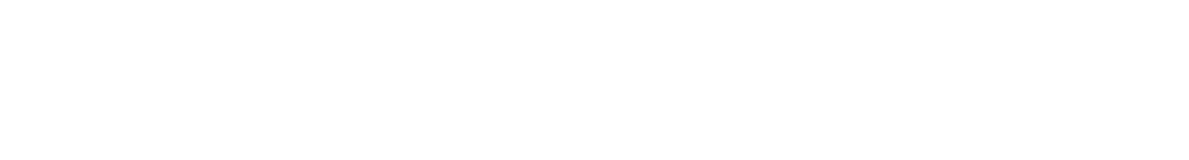
Frontiers in Built Environment |